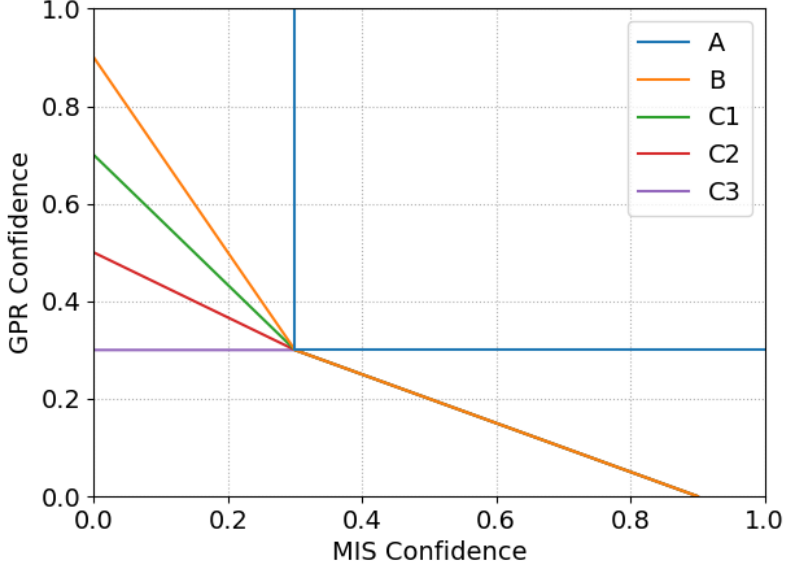
Figure 15. Decision surfaces showing how targets are classified based on the confidence from the two sensors, based on varying thresholds.